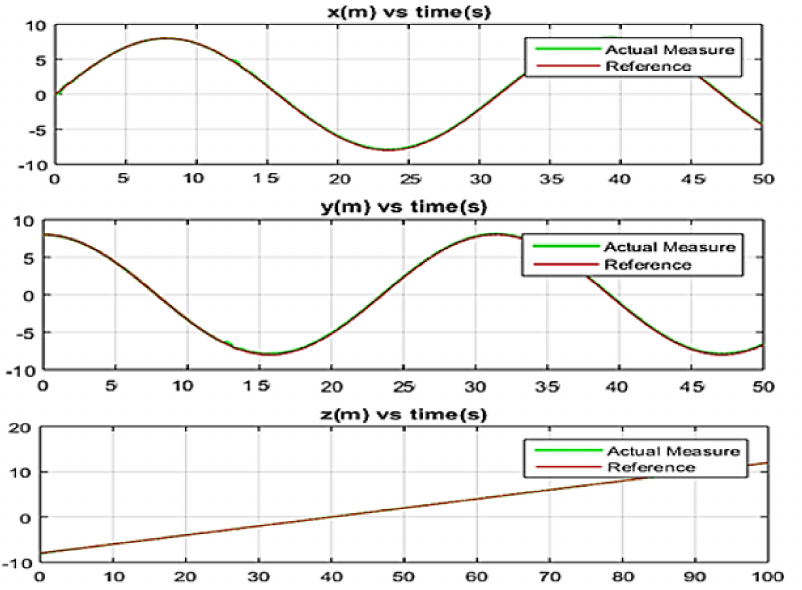
Figure 10. Helical trajectory tracking using Fuzzy based Backstepping control under unmodelled dynamic factors and external disturbances.